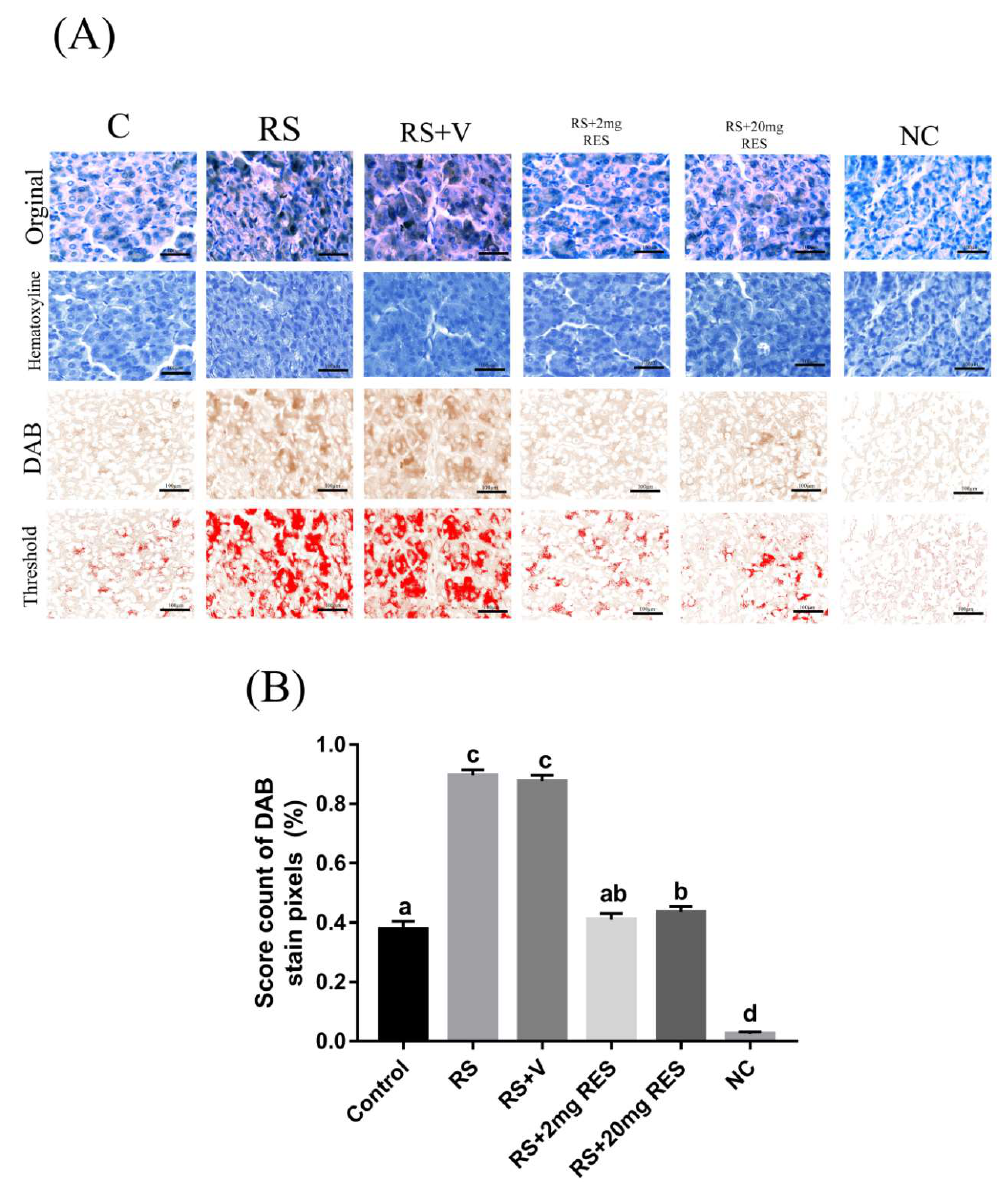
Figure 7. Representative digital images of the histogram profile showing 3, 3’-diaminobenzidine (DAB) brown staining and color pixel intensity for AIF in the parietal cells of the mouse stomach. The histogram profile corresponds to the pixel intensity value vs. the corresponding number of counts of pixel intensity. From top to bottom rows, panels show the digital image masks stained with hematoxylin, DAB, and threshold, respectively. The threshold function of ImageJ was used to place red spots on the DAB stains by setting different threshold levels, with the lower threshold at 0 and upper threshold at 110. ( A ) AIF is expressed in a limited quantity at the tight junction in parietal cells. Each bar in the given graph ( B ) represents the mean ± SEM (n = 12). Statistical differences were determined by 1-way ANOVA followed by Tukey’s multiple-comparison test. Different superscript letters represent significant differences among groups ( p < 0.05).